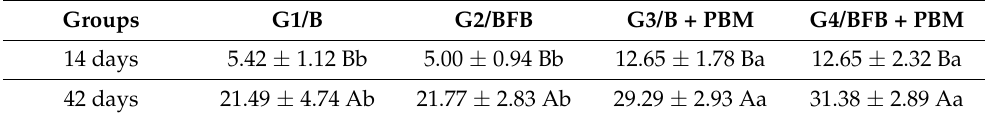
Table 2. Percentage of new bone formation in each group in the two experimental periods (14 and 42 days). G1/B defects filled with BCP; G2/BFB defects filled with BCP + fibrin biopolymer; G3/B + PBM defects filled with BCP and PBM therapy; and G4/BFB + PBM defects filled with BCP + fibrin biopolymer and PBM therapy.